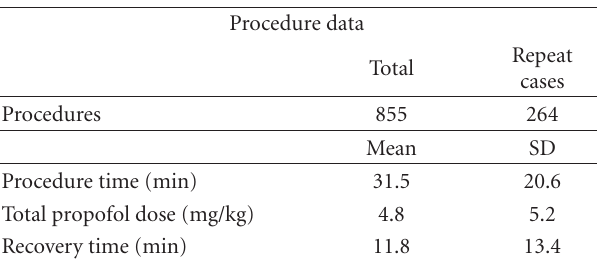
Table 3: Procedure